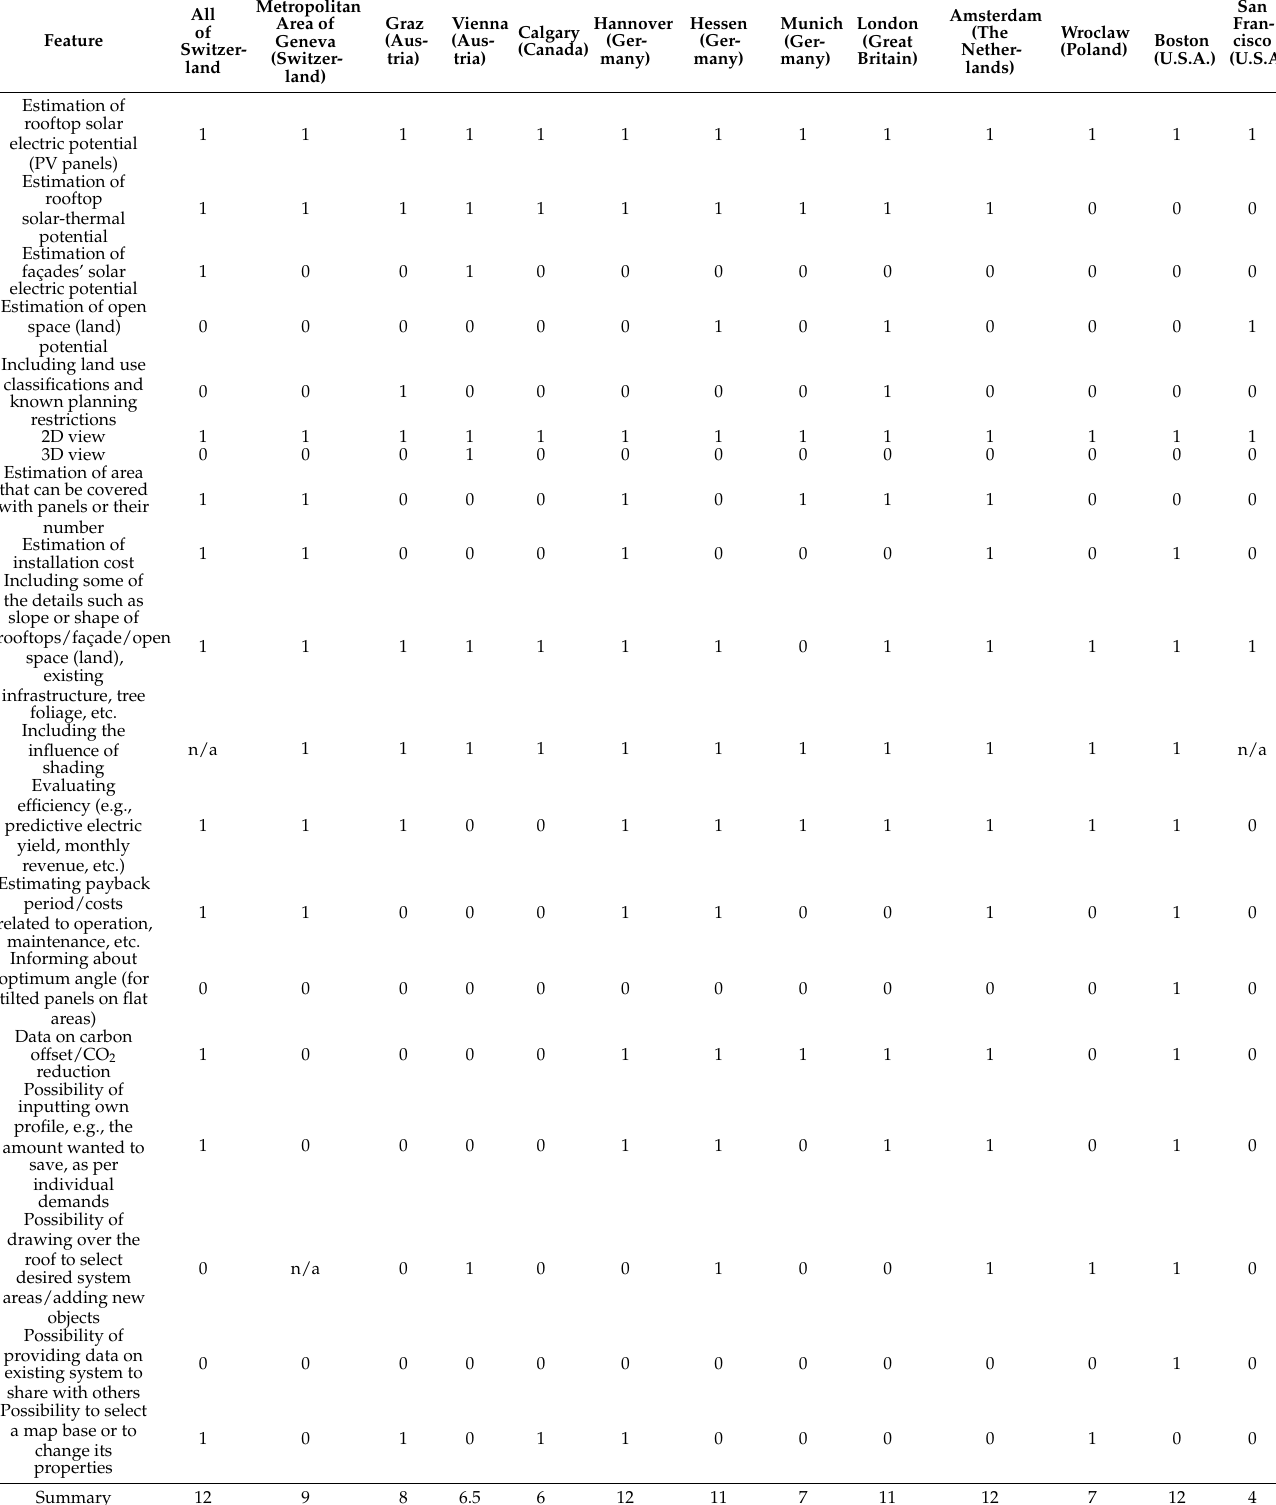
Table 6. Comparison of selected solar